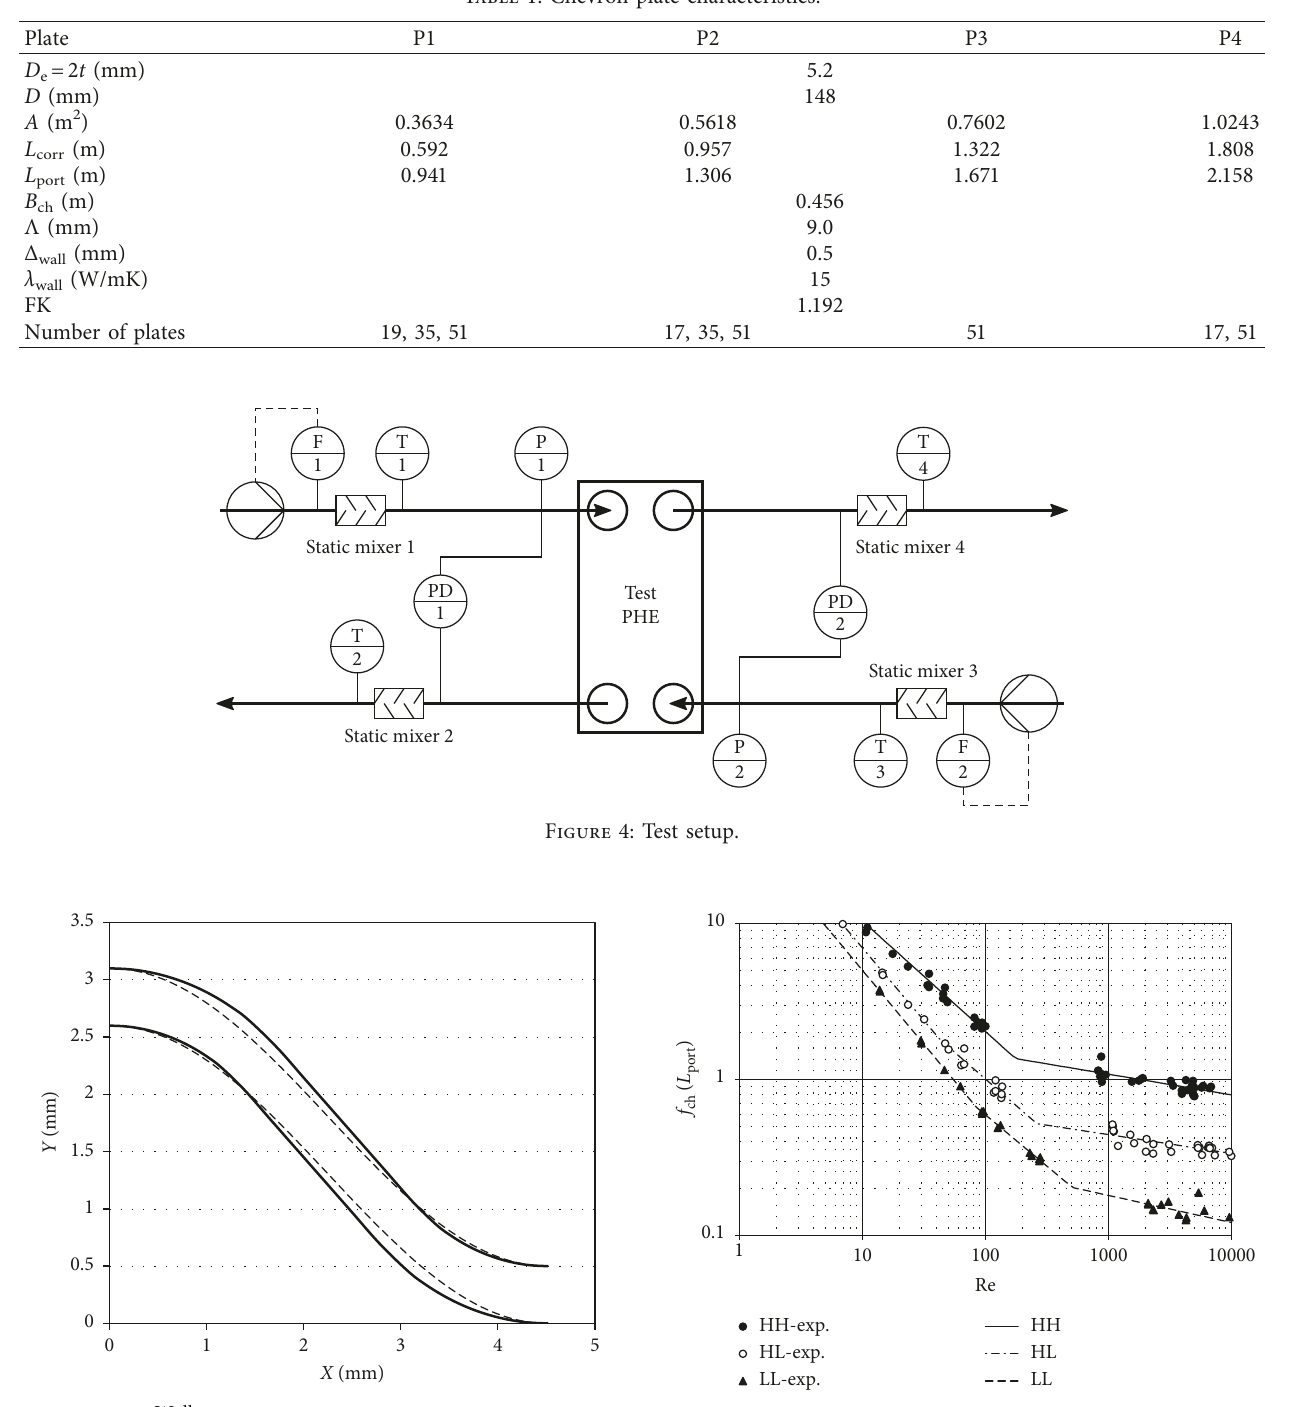
Figure 6: Fanning factor for plate P2 with 3 corrugations HH, HL, and